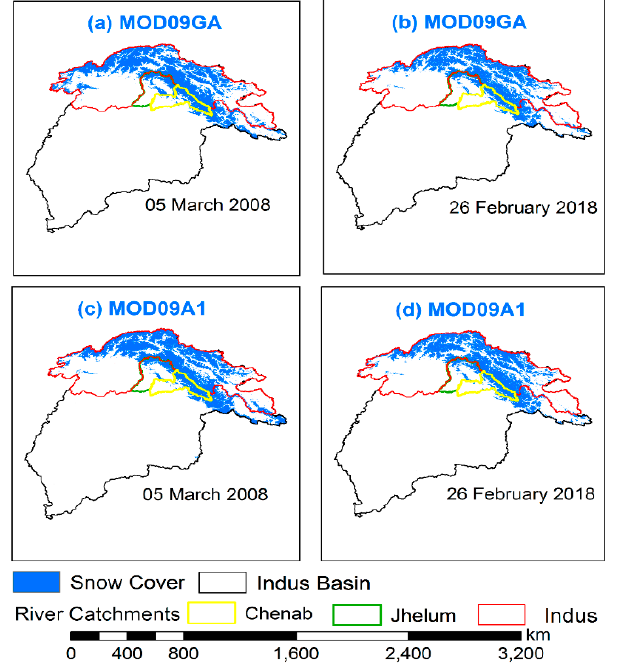
Figure 4. ( a – d ): Comparison of snow cover area delineated by MODIS MOD09GA and MOD09A1 products over the Indus basin and its rivers’ catchments. On 5 March 2008, both the MODIS products show a difference in their snow cover patterns, mainly on the western side (the Kabul river basin), northern side and the eastern rivers’ catchments of the basin. On 26 February 2018, both the MODIS products indicate almost similar snow cover patterns over the Indus basin. The snow cover patterns of both the MODIS products over the Indus basin indicate that the snow cover on the western side of the Indus basin and the eastern rivers’